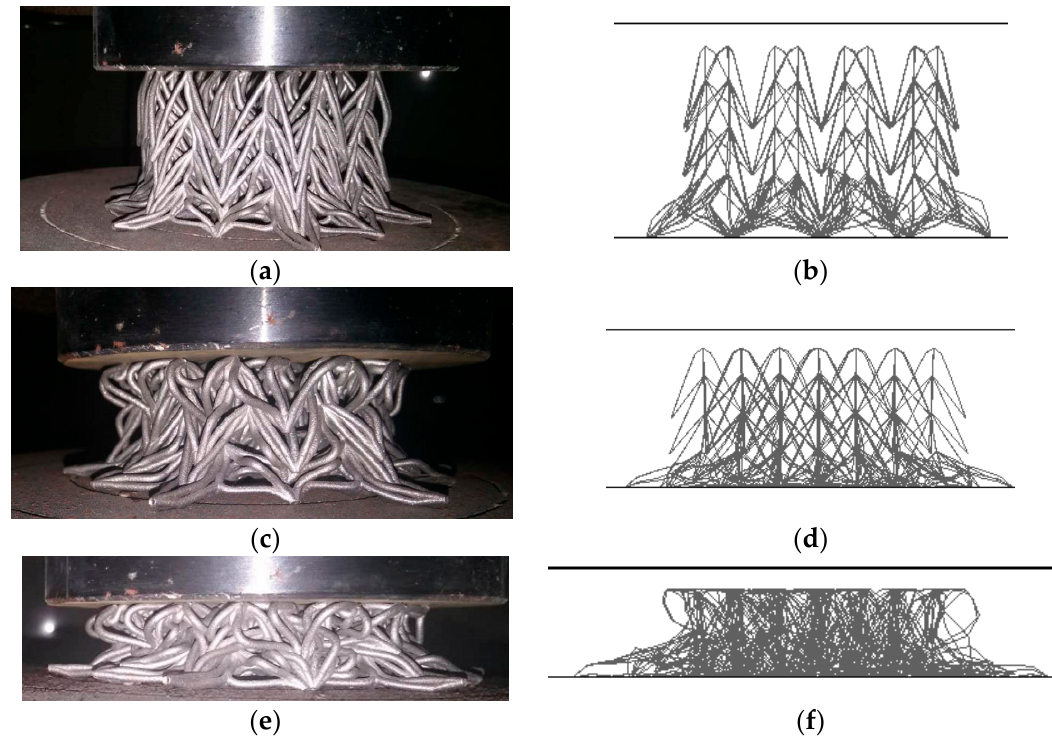
Figure 20. Comparison of compressive deformation process: ( a ) experiment, 10 mm deformation; ( b ) simulation, 10 mm; ( c ) experiment, 20 mm; ( d ) simulation, 20 mm; ( e ) experiment, 30 mm; ( f ) simulation, 30 mm.